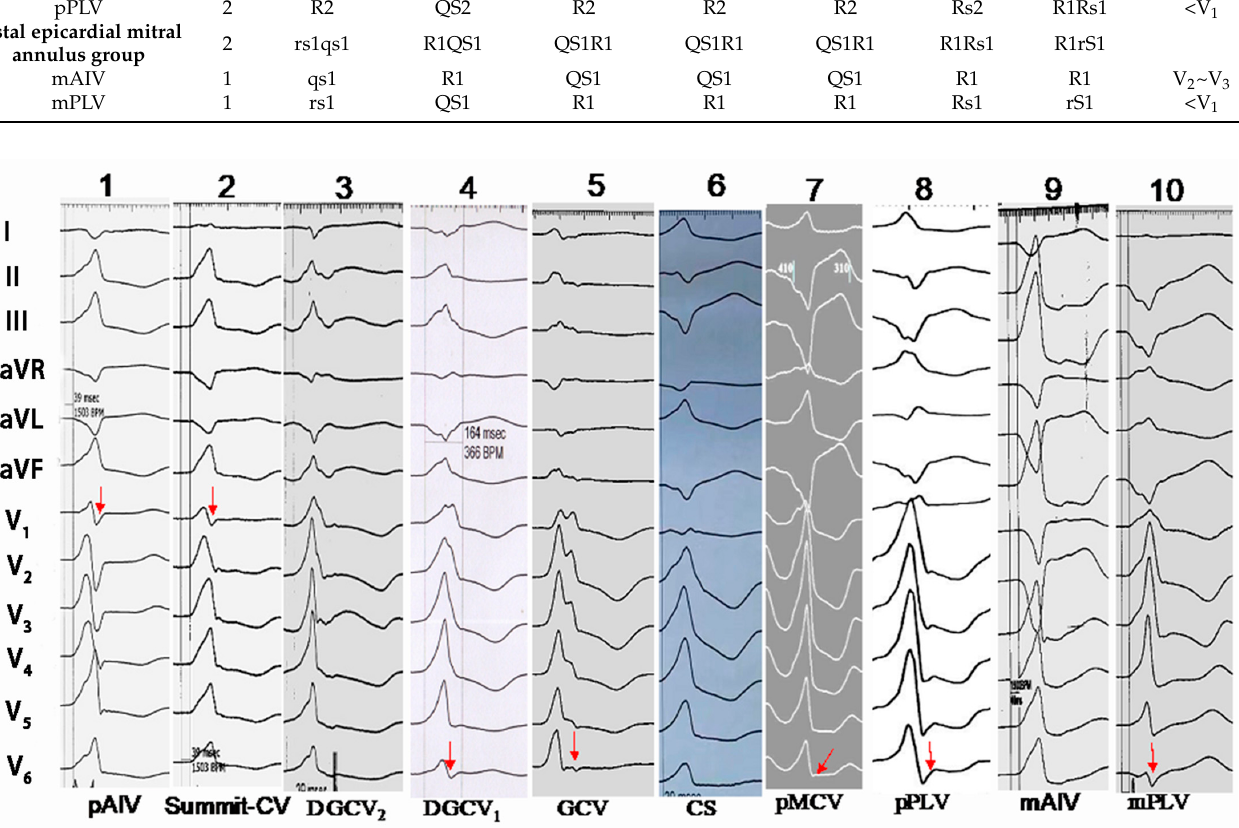
Figure 3. The QRS morphology of idiopathic ventricular arrhythmias (IVAs) originating from the CVS. pAIV, the proximal portion of the anterior interventricular vein; mAIV, the mid portion of the anterior interventricular vein; pMCV, the proximal portion of the middle cardiac vein; pPLV, the proximal portion of the posterior lateral vein; mPLV, the mid portion of the posterior lateral vein. Table 3. ECG characteristic of IVAS origin from the CVS.